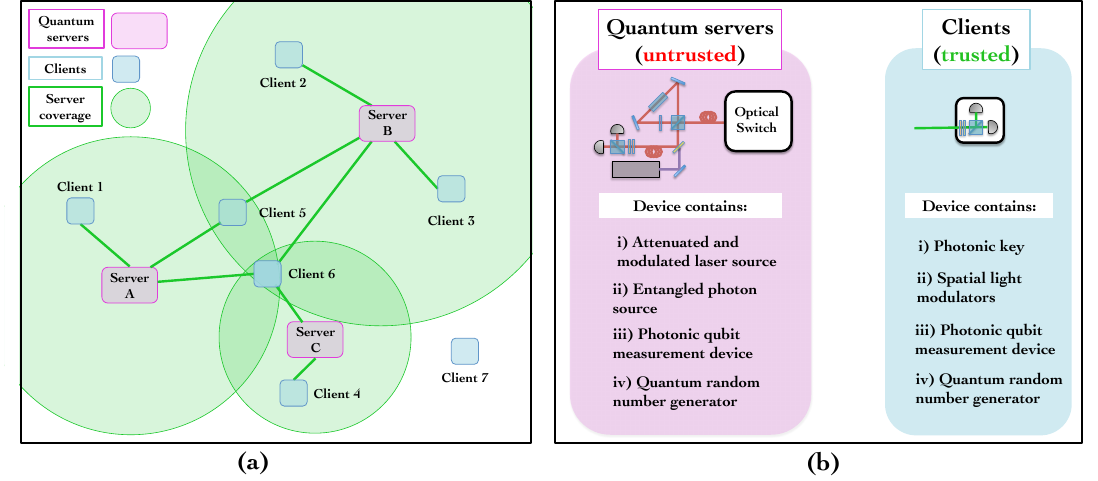
Fig. 2. High-level overview of the quantum-enabled blockchain and devices. a) Illustrates networking between an untrusted consortium of quantum servers (pink rectangles) and clients equipped with quantum modems (blue squares). Green links represent an insecure but au- thenticated classical communication channel and an authenticated quantum communication channel. Clients may access servers depending on the coverage map (green circles), with cov- erage radius depending upon infrastructure constraints. b) Presents an overview of the trust status and device subsystems required for interacting with the quantum-enabled blockchain. See main text for